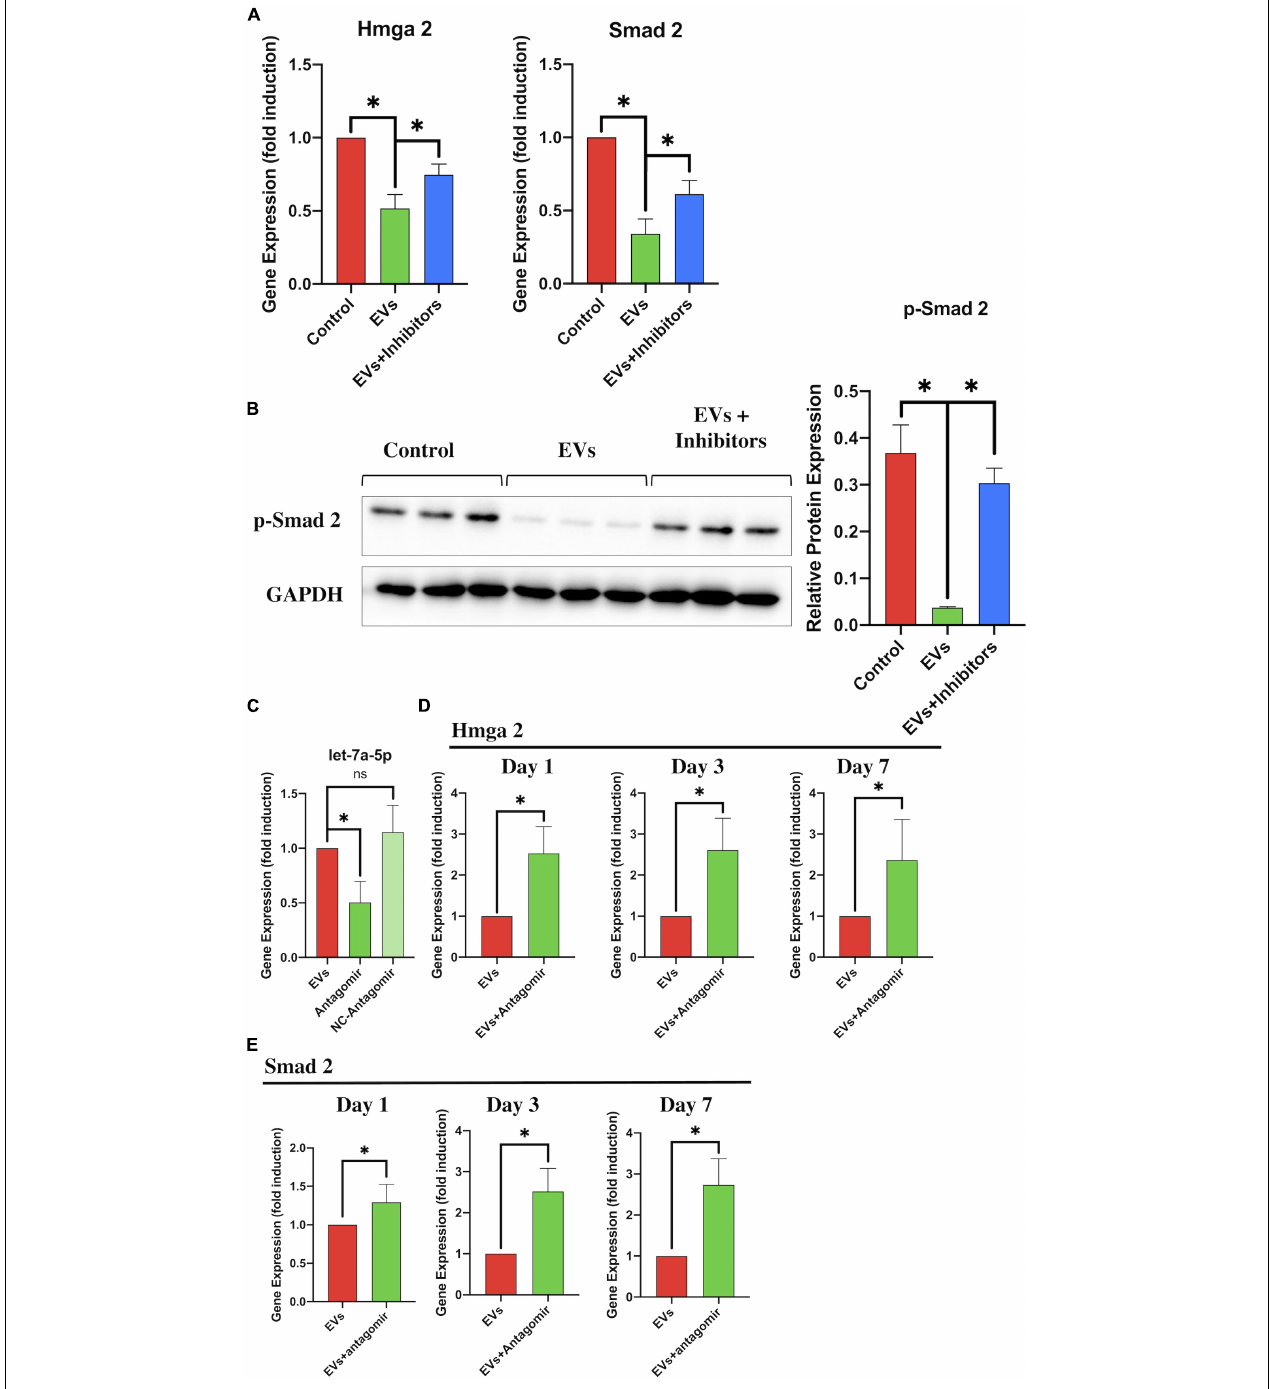
FIGURE 6 | let-7a-5p inhibitors repressed the BMSC-EV-induced effects on the HMGA2/SMAD2 axis. (A) RT-PCR analysis revealed that the expression of HMGA2 and SMAD2 in NSCs was reduced by the addition of let-7a-5p inhibitors in the presence of BMSC-EVs ( n = 3). (B) Western blot analysis also revealed that BMSC-EVs were able to reduce the expression of p-SMAD2 and that this BMSC-EV-induced regulation was partly attenuated by the addition of let-7a-5p antagomirs after 3 days of NSC culturing. (C) PCR analysis confirmed that the let-7a-5p antagomirs could reduce let-7a-5p expression ( n = 3). (D,E) Compared with the BMSC-EV-treated rats, the let-7a-5p antagomir injection repressed the BMSC-EV-associated downregulation of HMGA2 and SMAD2 expression in the early phase of SCI, leading to an increase in HMGA2 and SMAD2 expression in the injured lesion ( n = 3; data are shown as mean ± S.D; Student’s t- test was used for comparisons). Gene expressions were normalized to the GAPDH (for mRNA) and U6 snRNA (for miRNA). ∗ p < 0.05. The term BMSC-EVs is abbreviated as EVs and let-7a-5p agomir is abbreviated as agomir.